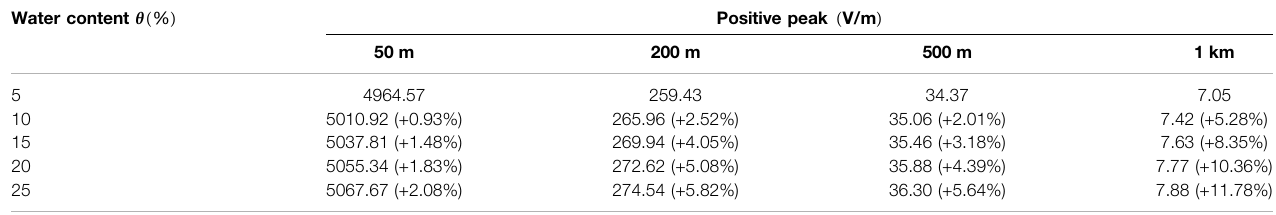
TABLE 4 | Positive peak values of the horizontal electric fi eld (Er) for different water contents θ at different distances d (cid:2) 50m, 200m, 500m, and 1km from the lightning channel; φ (cid:2) 40%; h (cid:2) 10m; The change rate of the values at different water contents relative to that at the water content of 5% is marked in parentheses.